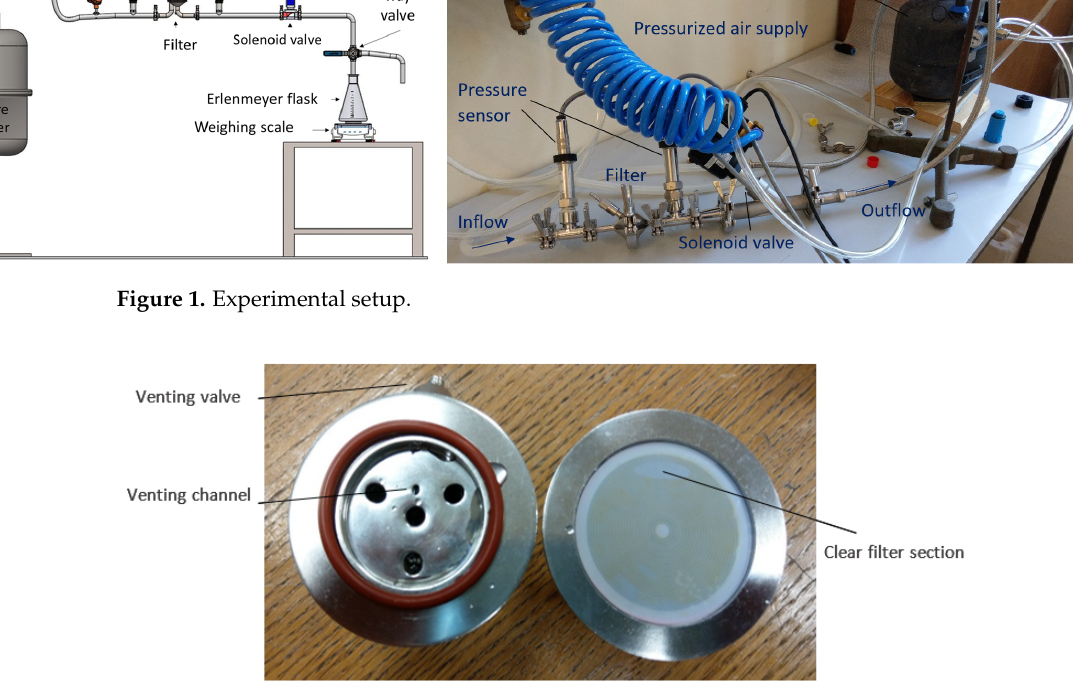
Figure 2. Filter casing ( left ) and support plate ( right ).